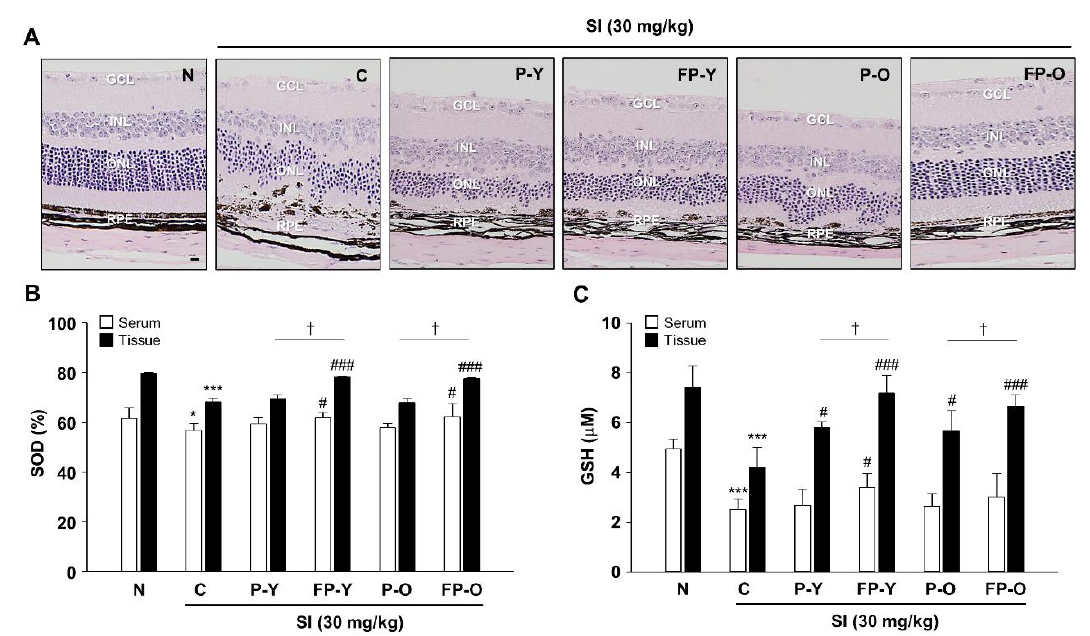
Figure 4. FP protect SI-induced retinal morphological impairment in mice. ( A ) The enucleated eyes were stained with hematoxylin and eosin (H and E). Histological images showing the alterations in retinal morphology. The magnification was × 200. Scale bar = 20 µ m. ( B ) Superoxide dismutase (SOD) and ( C ) glutathione (GSH) levels were measured in serum and tissue lysates from all groups using an enzyme-linked immunosorbent assay (ELISA) kit. * p < 0.05, *** p < 0.001 vs. N; # p < 0.05, ### p < 0.001 vs. C. † p < 0.05 vs. P (-Y or -O). Values are means ± SEM. Significant differences between the groups were determines by ANOVA followed by Duncan’s multiple range test. GCL, Ganglion cell layer; INL, Inner nuclear layer; ONL, Outer nuclear layer; RPE, Retinal pigment epithelium; N, Normal; C, Control; P-Y, Yellow Paprika; P-O, Orange Paprika; FP-Y, Fermented P-Y; FP-O, Fermented P-O.